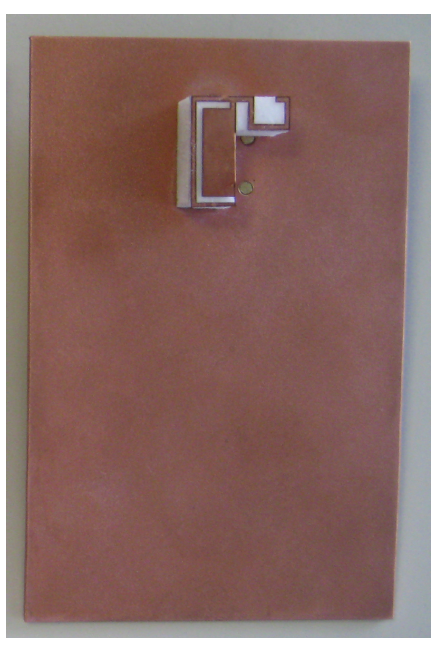
Figure 2: Triband radiating element with an SMA connector (dimensions are in mm).